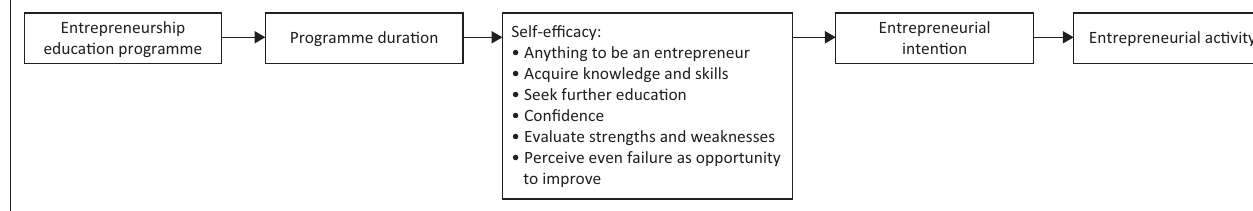
FIGURE 1: Conceptual